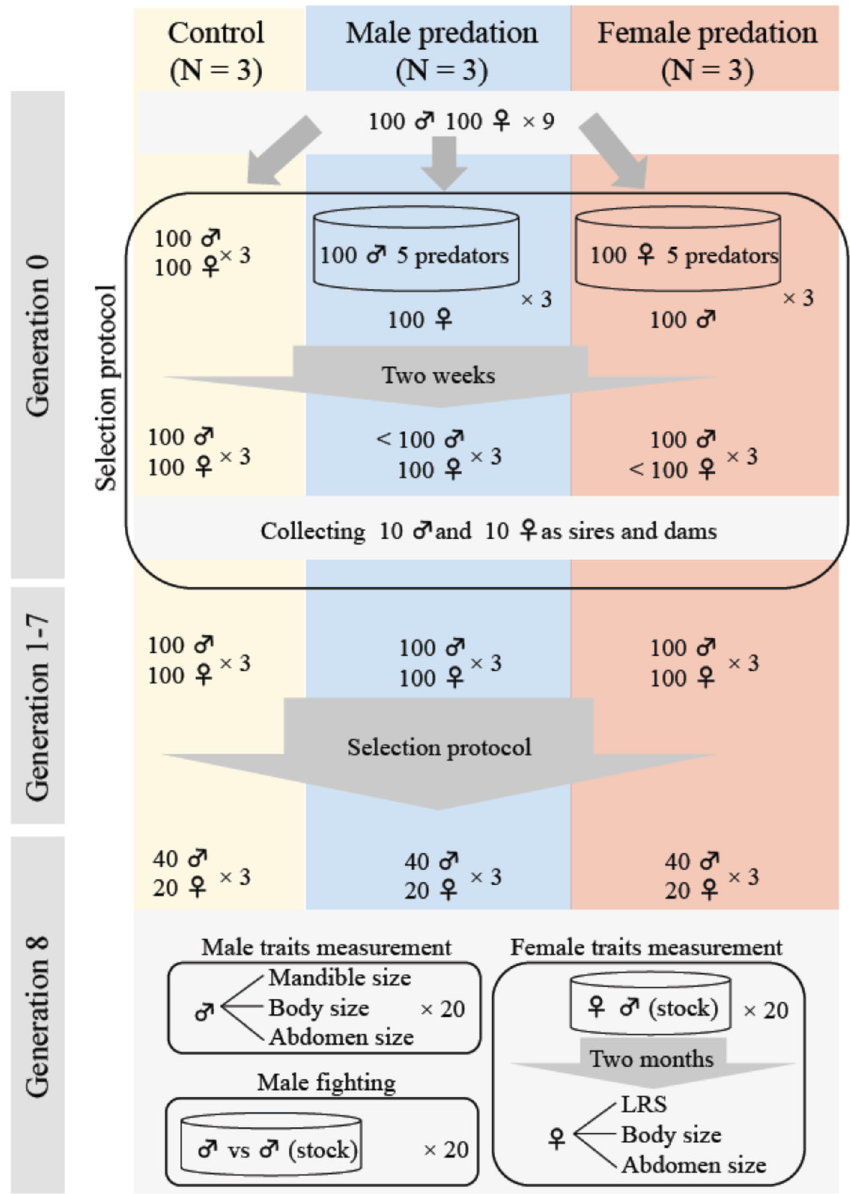
Fig. 5 A diagrammatic representation of the experimental evolution protocol. Included is the fi ghting assay after eight generations of experimental evolution. N refers to the number of replicate